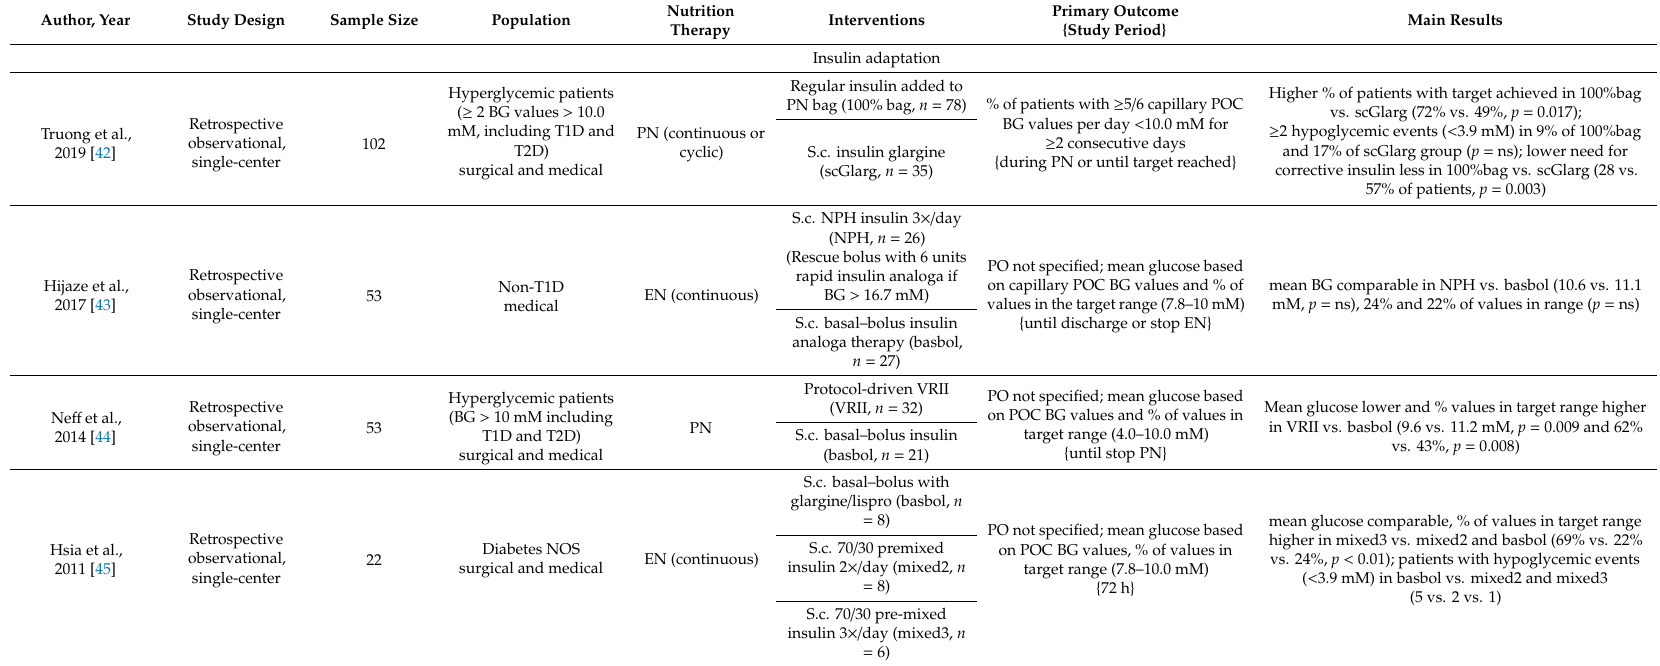
Table 2. Overview of observational, retrospective